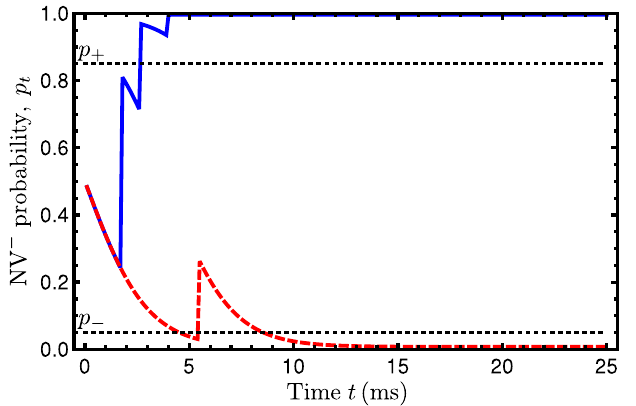
for a trajectory t correspond to the t first t and p − (dotted black) or when þ 25 M ¼